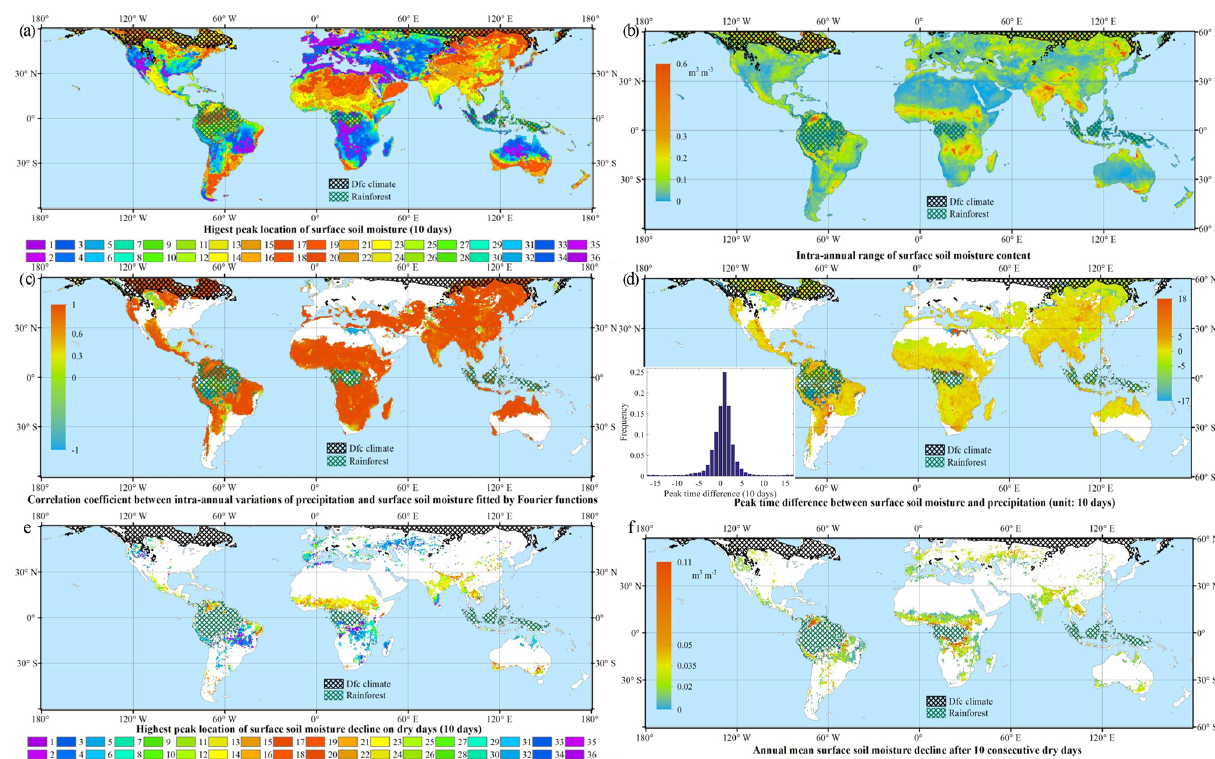
Figure 15. Intra-annual variation in global surface soil moisture and its relationship with precipitation. (a) Spatial pattern of the time when surface soil moisture reaches its maximum in a year (unit: 10d; note that the seasons are opposite in the northern and southern hemispheres); (b) intra-annual variation range of surface soil moisture; (c) map of the correlation coefficient between the intra-annual variations in precip- itation and surface soil moisture (both are fitted by Fourier periodic functions); (d) peak time difference between the surface soil moisture and precipitation (unit: 10d), with the frequency histogram shown as the inset; (e) 10d period with the fastest surface soil moisture loss on rainless days in every 0.5 ◦ grid cell over the world; and (f) map of the annual mean surface soil moisture decline after 10 consecutive dry days (assuming that the dry period occurs randomly throughout a year).